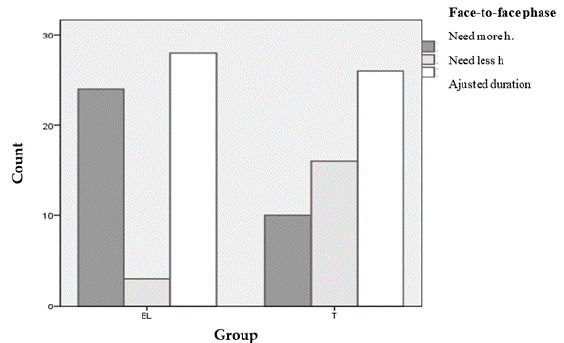
Figure 8. Duration of the face-to-face phase: student preferences.